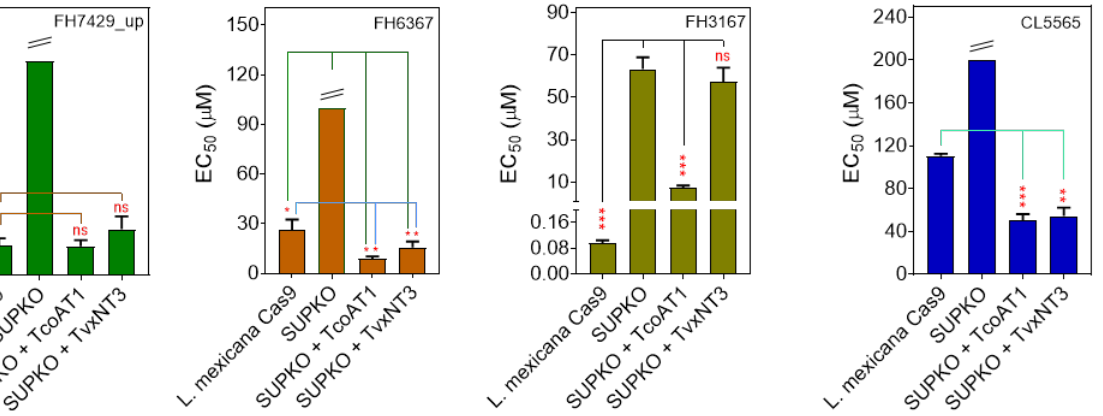
Figure 8. The sensitivity of T. congolense and T. vivax nucleoside transporters to nucleoside analogs. The expression of TcoAT1 and TvxNT3 in SUPKO restored sensitivity to tubercidin analogs. Sensitivity is represented as EC 50 averages of three independent determinations (mean ± SEM). * p < 0.05; ** p < 0.01; *** p < 0.001; ns = not significant by unpaired Student’s t -test compared with SUPKO. The double line above some bars indicates that the true value could not be extrapolated beyond 250 µM. Table 5. Effect of the expression of nucleoside transporters on the sensitivity of tubercidin analogs.